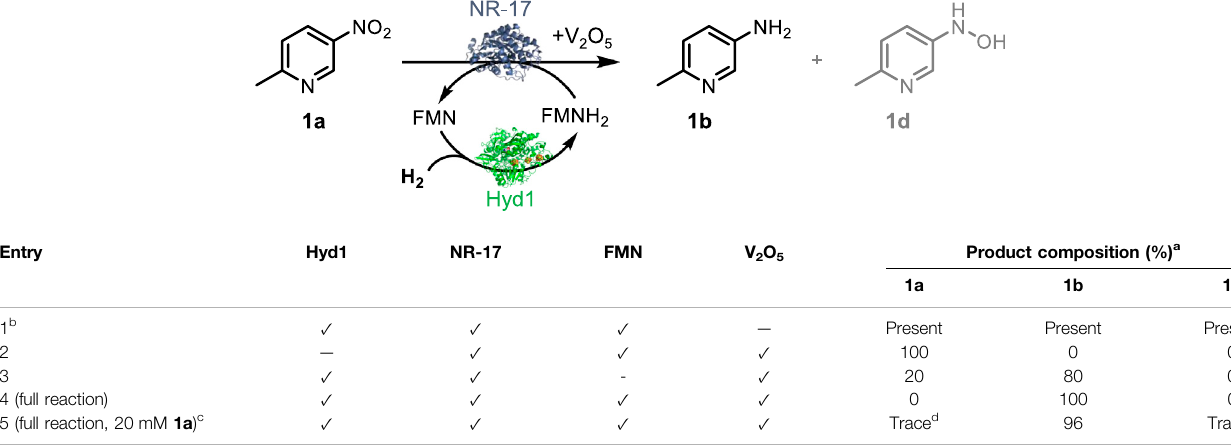
Entry Hyd1 NR-17 FMN V 2 O 5 Product composition (%) a 1a 1b 1d 1 b ✓ ✓ ✓ — Present Present Present 2 — ✓ ✓ ✓ 100 0 0 3 ✓ ✓ - ✓ 20 80 0 4 (full reaction) ✓ ✓ ✓ ✓ 0 100 0 5 (full reaction, 20 mM 1a ) c ✓ ✓ ✓ ✓ Trace d 96 Trace